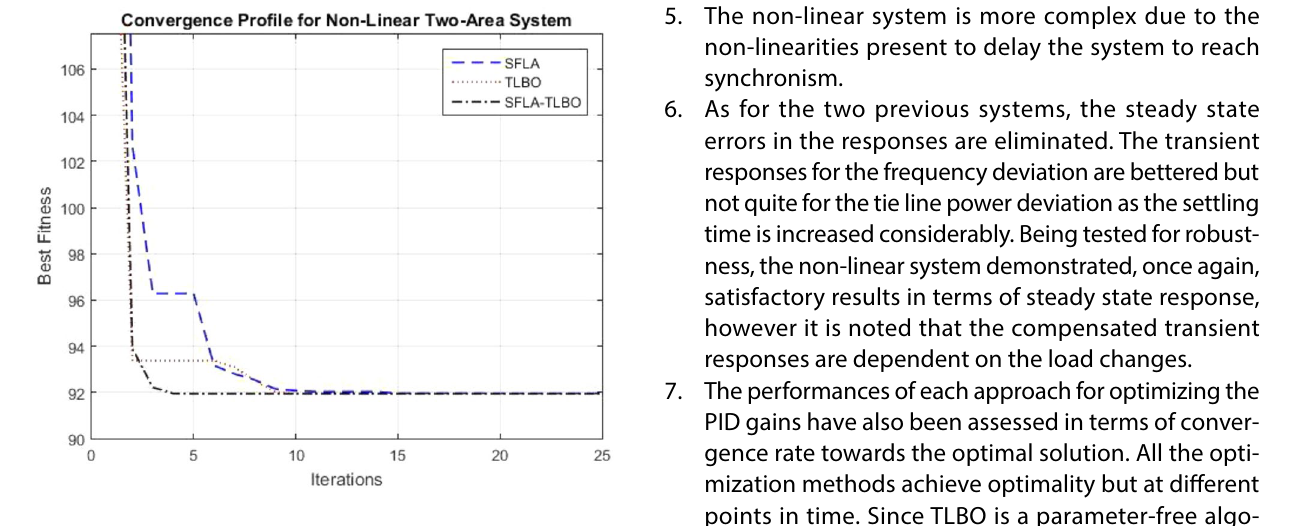
dead band and boiler dynamics as real-life systems are